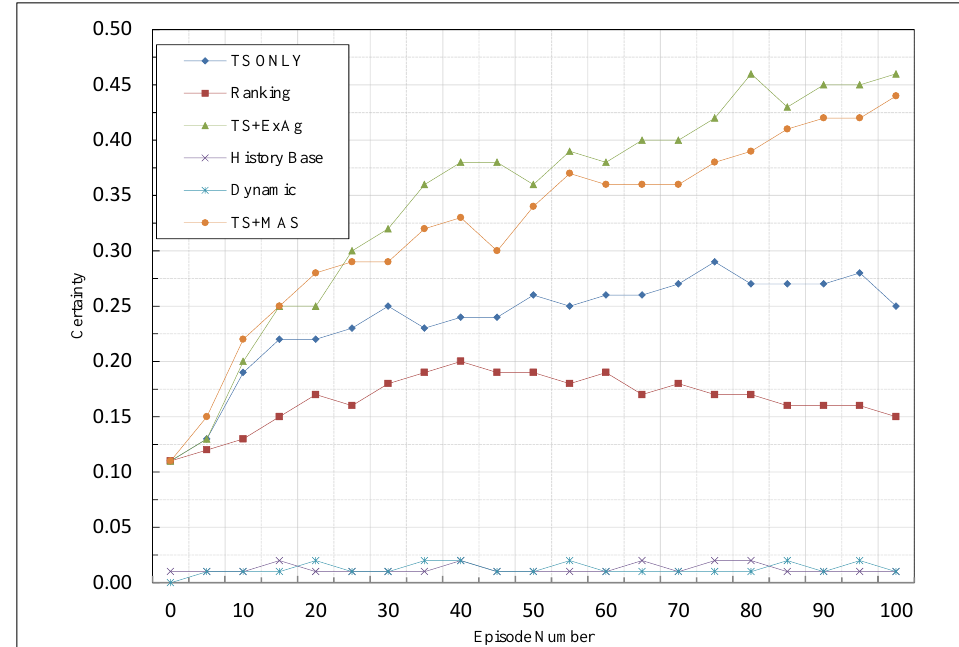
Figure 6. Comparison of MCA methods based on certainty